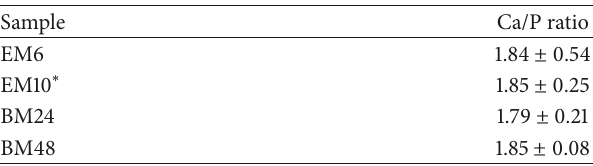
Table 3: Composition (Ca/P ratio) of different coatings obtained by EDX; ∗ is used for further cell analyses.